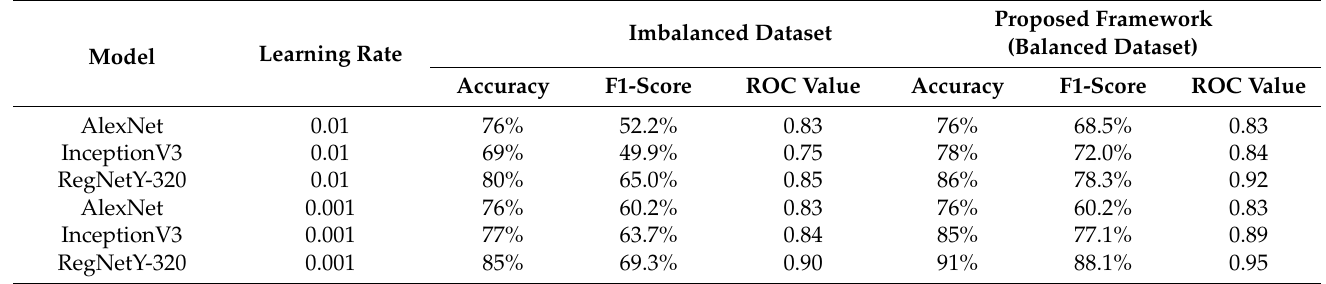
Table 3. The comparison of the performance on imbalanced data and the proposed framework.